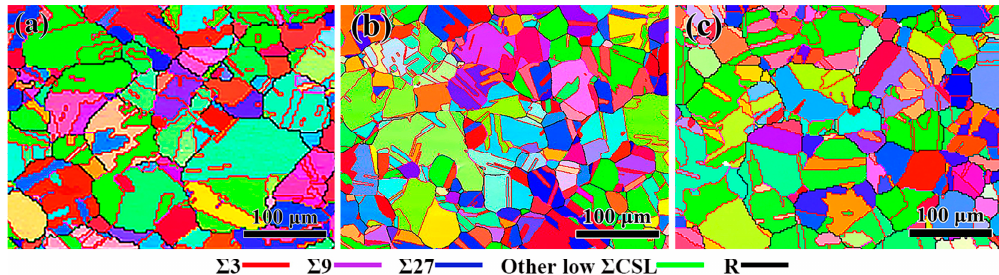
Figure 4. IPF of GBE samples: ( a ) Ni-5at.%Cr; ( b ) Ni-20at.%Cr; ( c ) Ni-40at.%Cr.